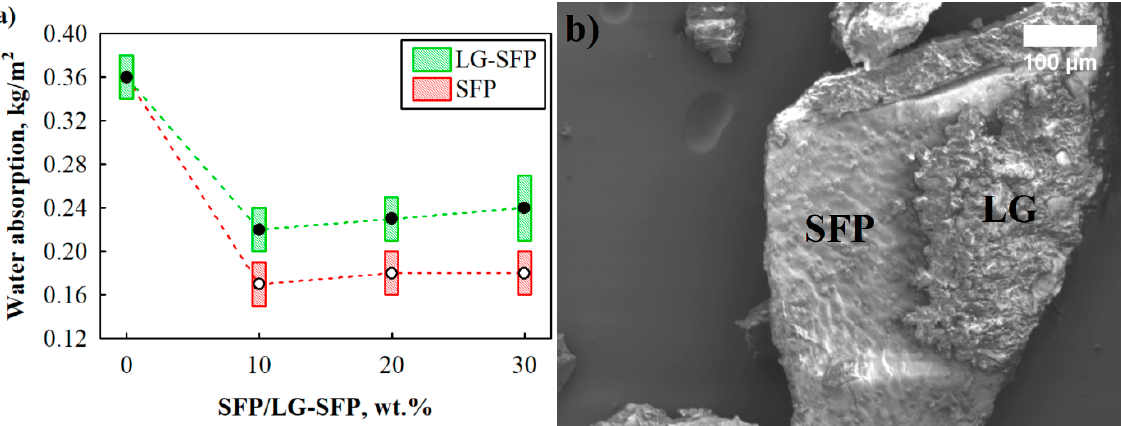
Figure 4. Water absorption of PUR-REF, SFP and LG-SFP modified PUR foams: ( a ) short-term water absorption and ( b ) LG-SFP particle and bonding boundary of oil and LG. Table 4. Apparent density and microstructural characteristics of SFP and LG-SFM modified PUR